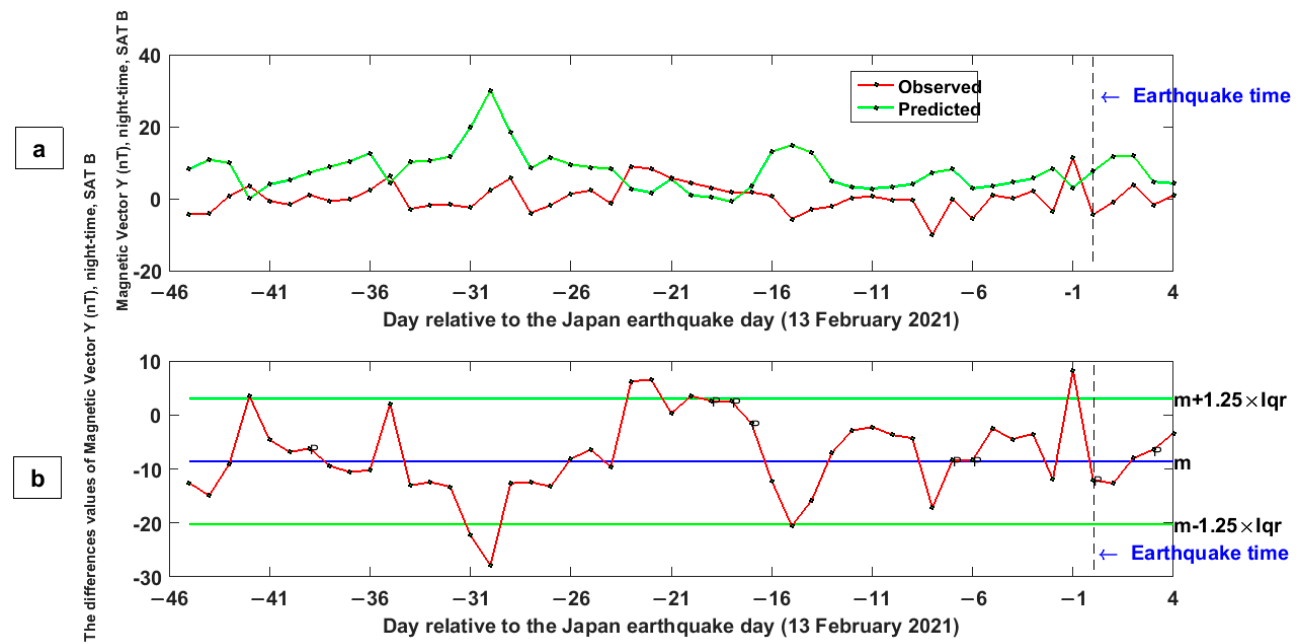
Figure 9. ( a ) Variations of the observed (red curve) and the predicted (green curve) night-time Y magnetic field measured by Swarm B and obtained by the LSTM method during testing days. ( b ) Variations of the differences between the observed and the predicted values of the Y magnetic field obtained by the LSTM method during testing days. The geomagnetically “perturbed” days are highlighted by a “P”.